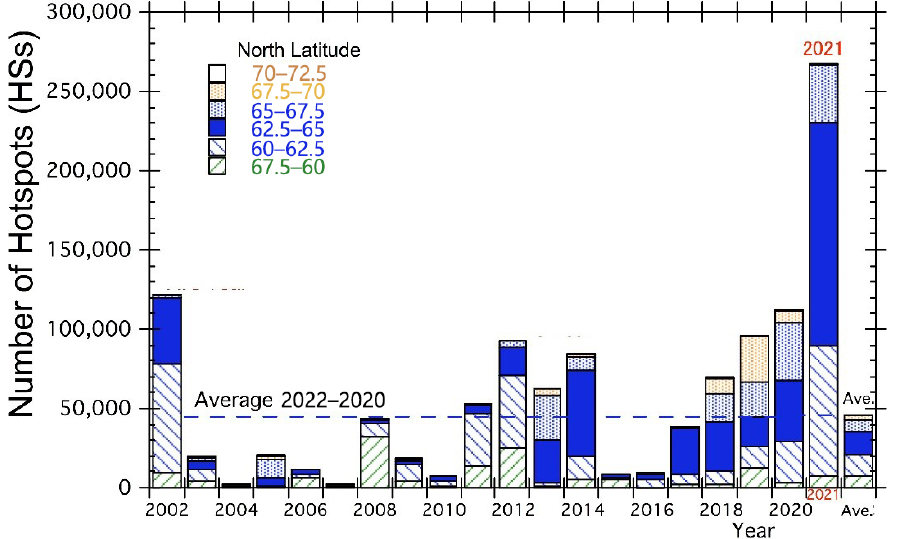
Figure 2. Recent fire history in Sakha from 2002 to 2020, and 2021 (until 9 September). In 2021, the accumulated daily number of HSs up to 9 September was 267,677—5.82 times larger than average values of the previous 19 years. Thus, 2021 was by far the most active fire season on record, followed by